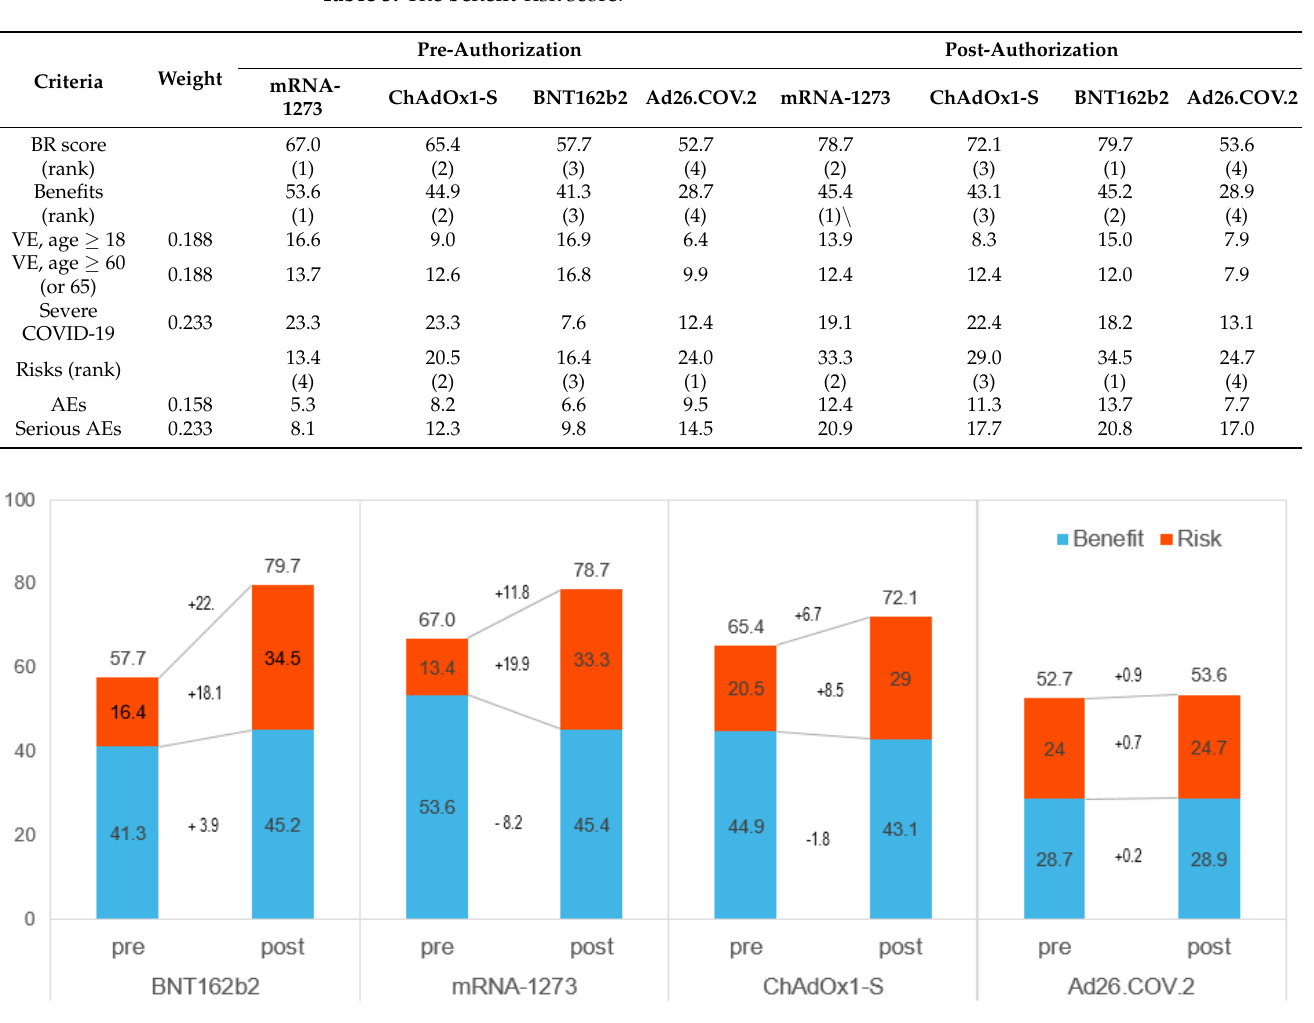
Table 3. The benefit-risk score.